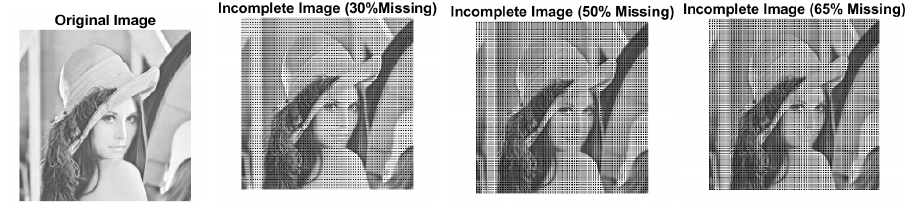
Figure 1. (Numerical Test 1) The original Lena image and incomplete images with 30%, 50%, and 65% missing pixels distributed uniformly over the image.